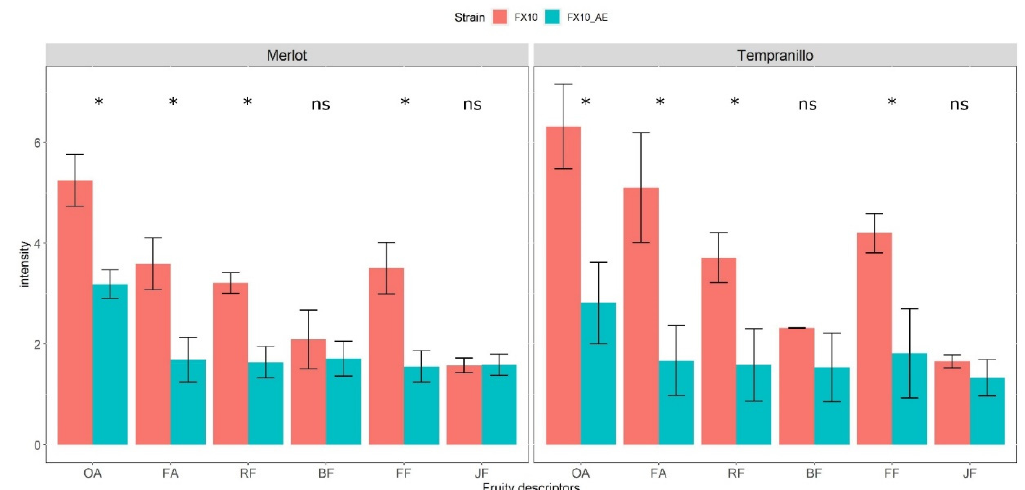
Figure 3. Sensory analysis of fruity perception of nearly “ester free” wines. Wines fermented by the yeast strains Fx10 and Fx10- Δ AE were evaluated by sensorial analysis by 26 panelists who evaluated the intensity of different fruity descriptors: OA: overall aroma, FA: fermentative aroma, RF: red fruit, BF: black fruit, FF: fresh fruit, JF: jammy fruit. The average intensity value for each descriptor and each strain is represented for the Merlot and Tempranillo wines. A Wilcoxon test was carried out to identify the difference of intensity between the two strains; the symbol * indicates a significant difference ( α = 0.05).